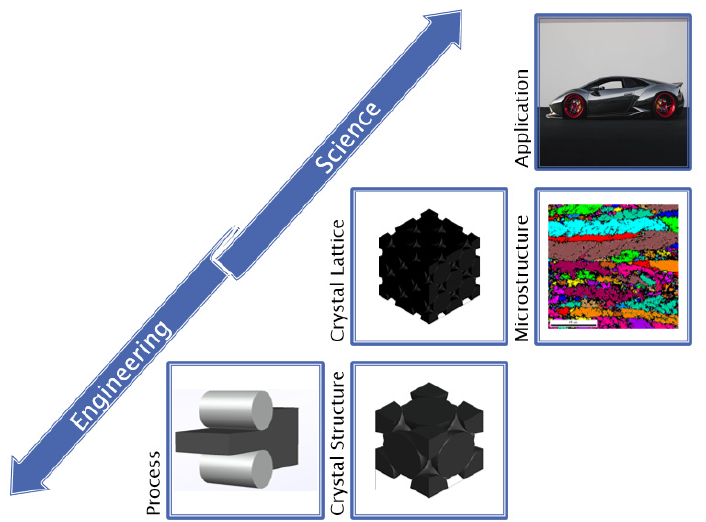
Figure 2. Schematic representation of the ICME approach based on Cohen’s reciprocity.